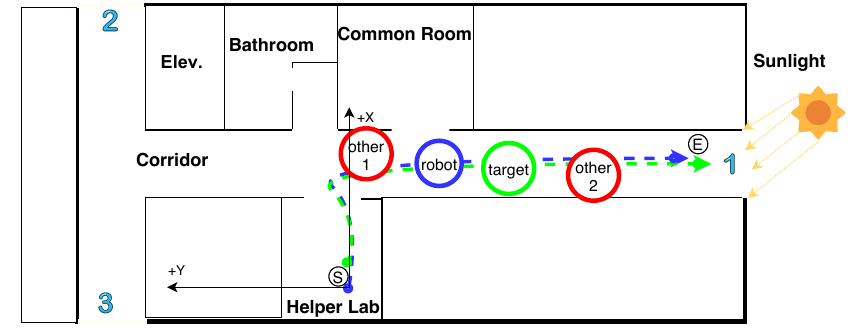
Figure 7. Realistic scenario of paths of the robot and the target in human